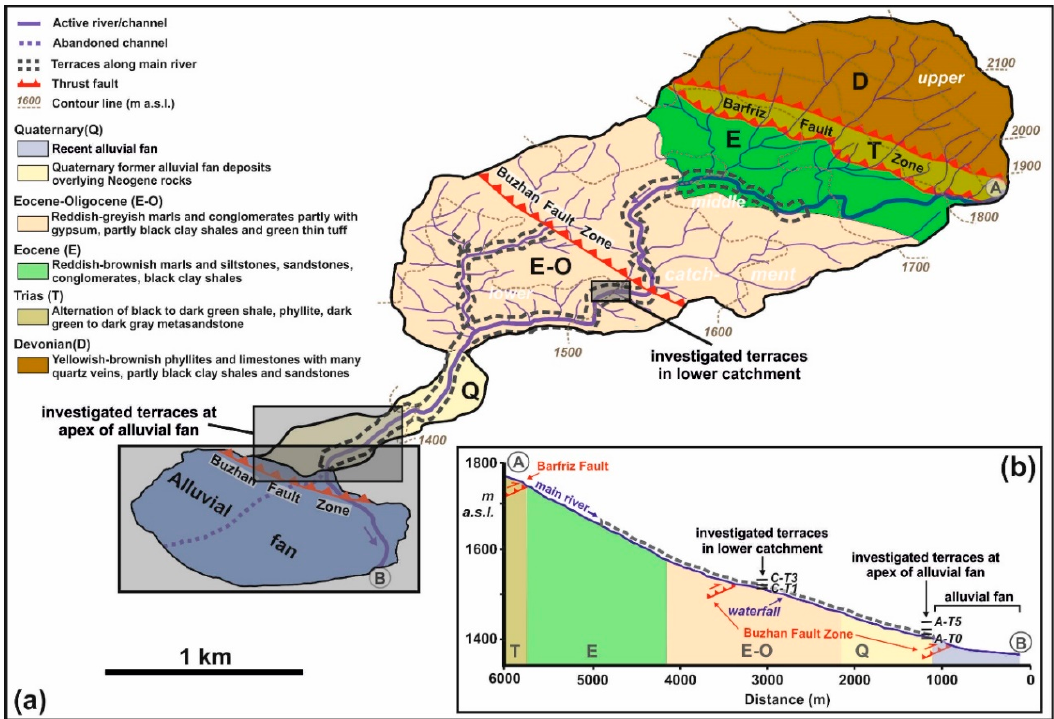
Figure 3. ( a ) Geological and geomorphological map of the studied Kalshur river system. The three studied sites are marked with grey rectangles. ( b ) Altitudinal profile along the main eastern river in the catchment and the currently active southeastern river channel on the present-day alluvial fan (from A to B). The profile was created based on measurements with the barometric altimeter of a hand-held Global Positioning System (GPS) device. The geology of the figures is based on the geological map 1:25,000 sheet Kharv [48], but was modified according to own field observations. The locations of main faults were provided by Esmail Shabanian (oral communication 2020). The distribution of terrace levels along the river courses is based on our own field observations.